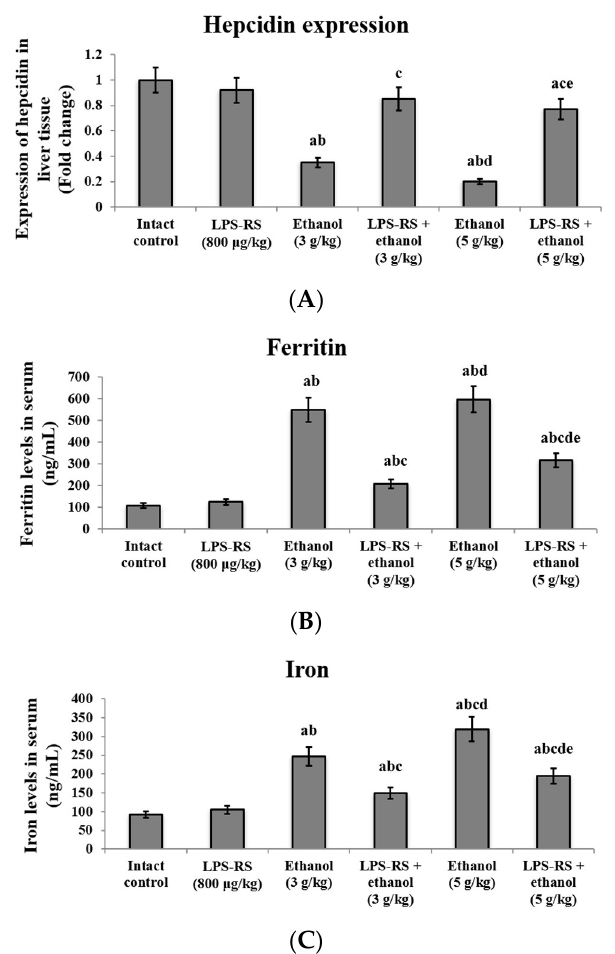
Figure 3. The effect of LPS-RS (800 μg/kg) on the iron homeostasis markers in the experimental rats. ( A ) the expression of hepcidin in liver tissue, serum levels of ( B ) ferritin and ( C ) iron. Data are expressed as mean ± SD and analyzed using one-way ANOVA followed by Bonferroni’s post-hoc test ( n = 8–10). Differences were considered significantly different at p < 0.05. a vs. intact control; b vs. LPS-RS; c vs. ethanol (3 g/kg); d vs. LPS-RS + ethanol (3 g/kg); e vs. ethanol (5 g/kg).